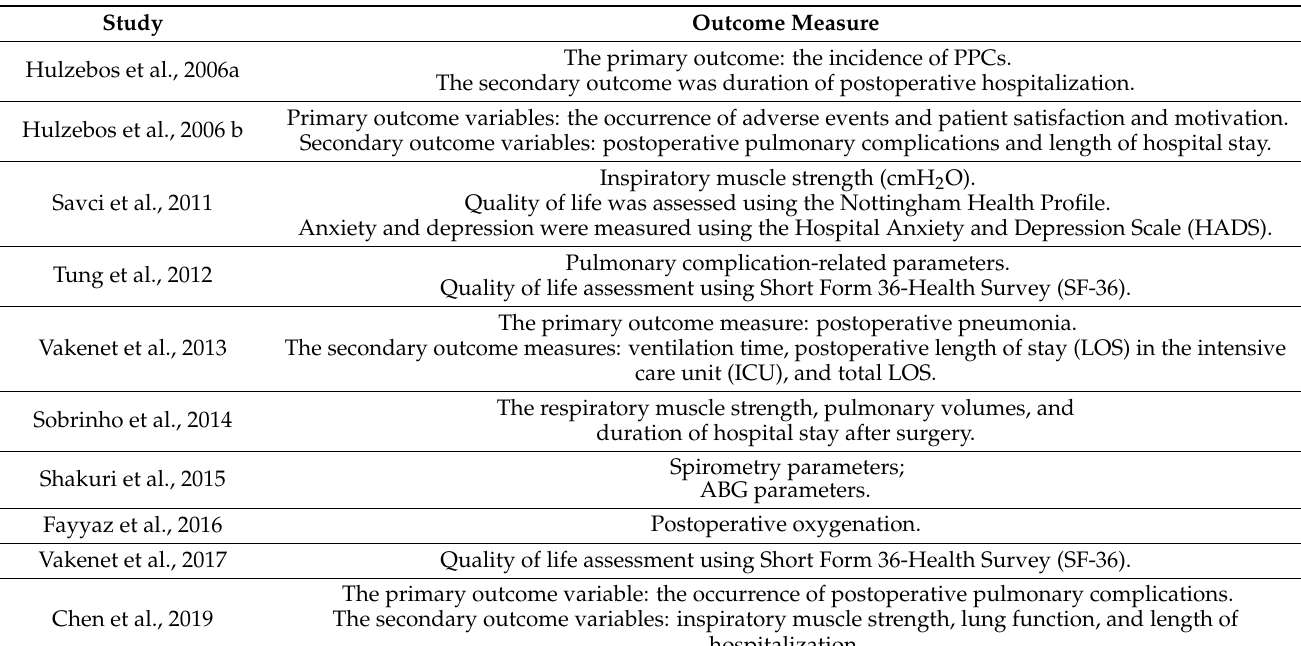
Table 6. The outcomes of the included